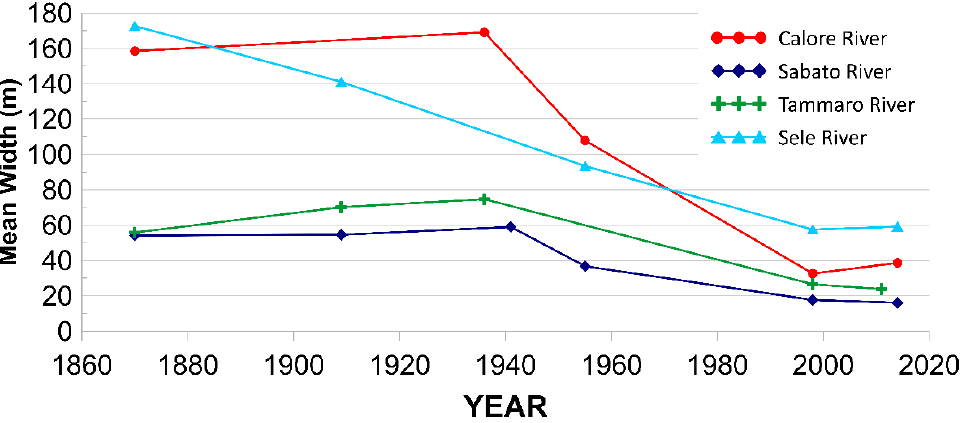
Figure 2. Changes in channel mean width (CMW) over the period 1870–2014.